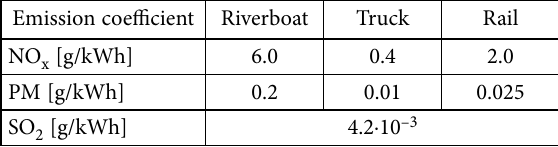
Table 3. Engine emission limits per transport mode